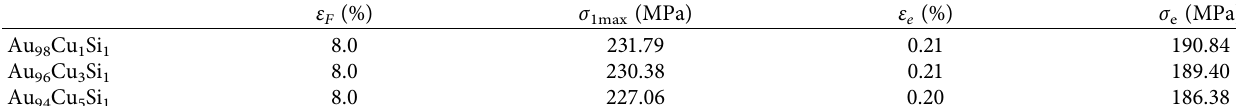
Table 2: Values of ε � f F ( f ( ε F ) max ), σ 1max , σ e , and ε e of Au 99 − x Cu x Si 1 at